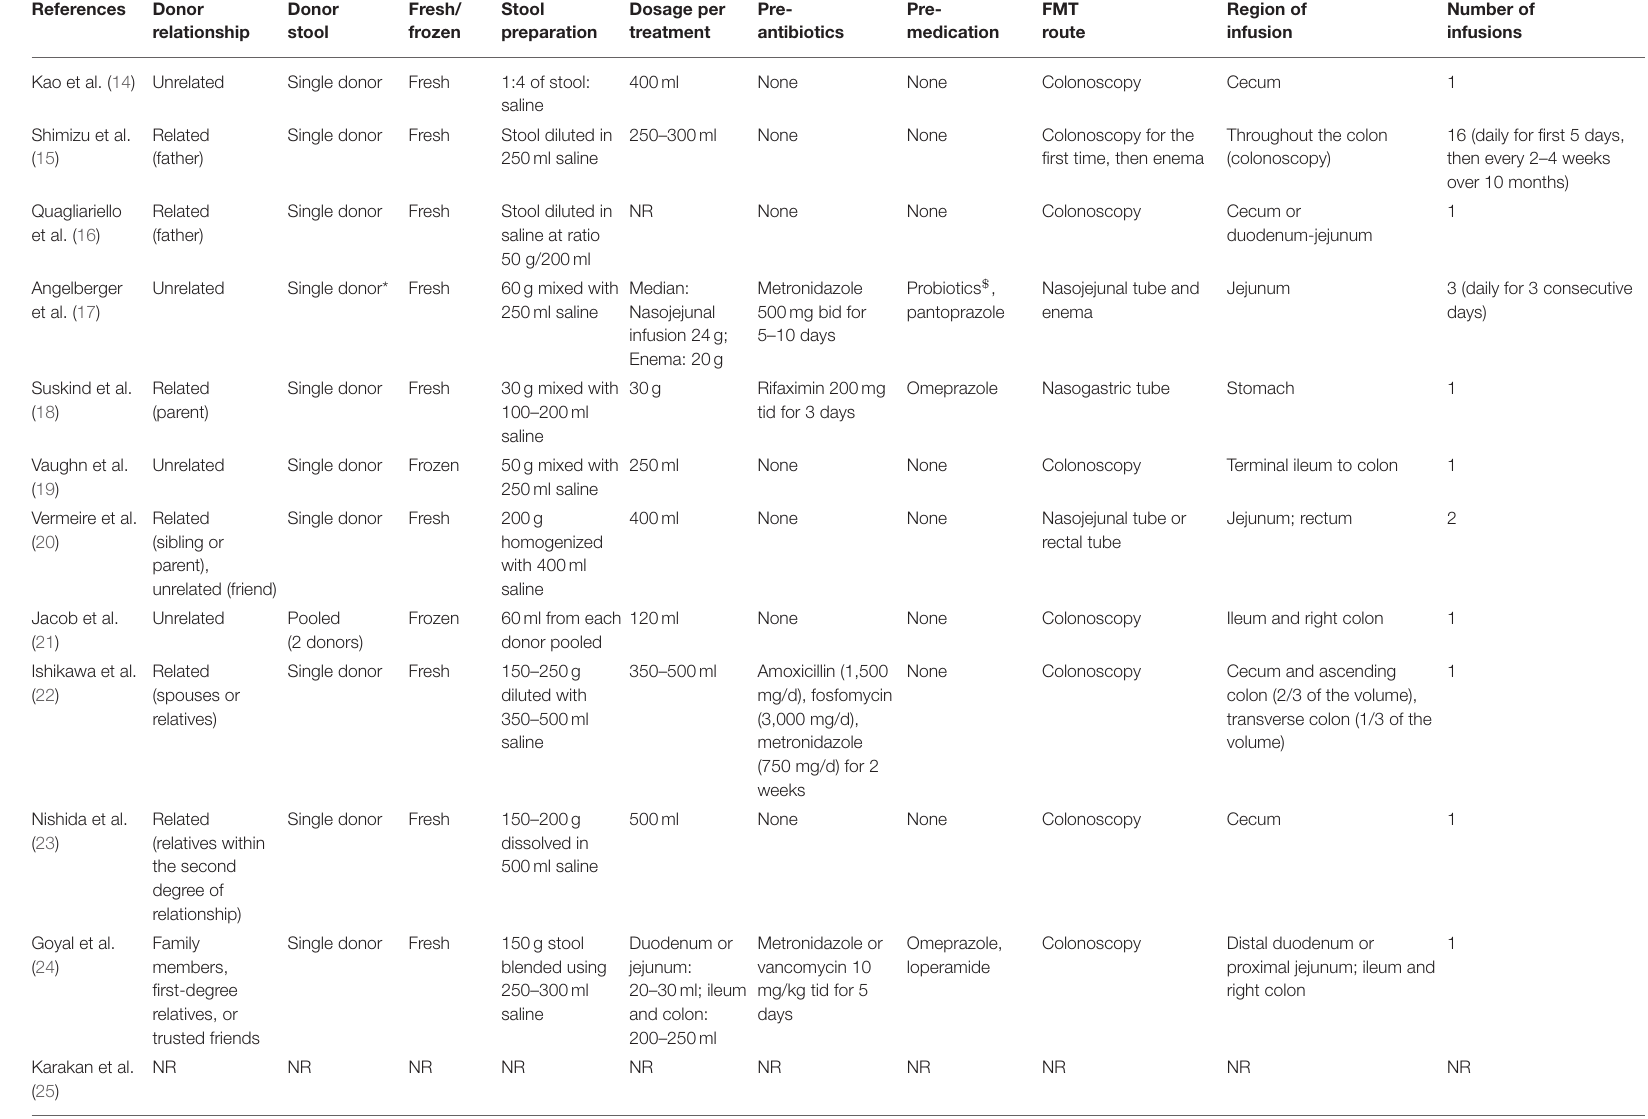
TABLE 1 | Summary of stool preparation and delivery